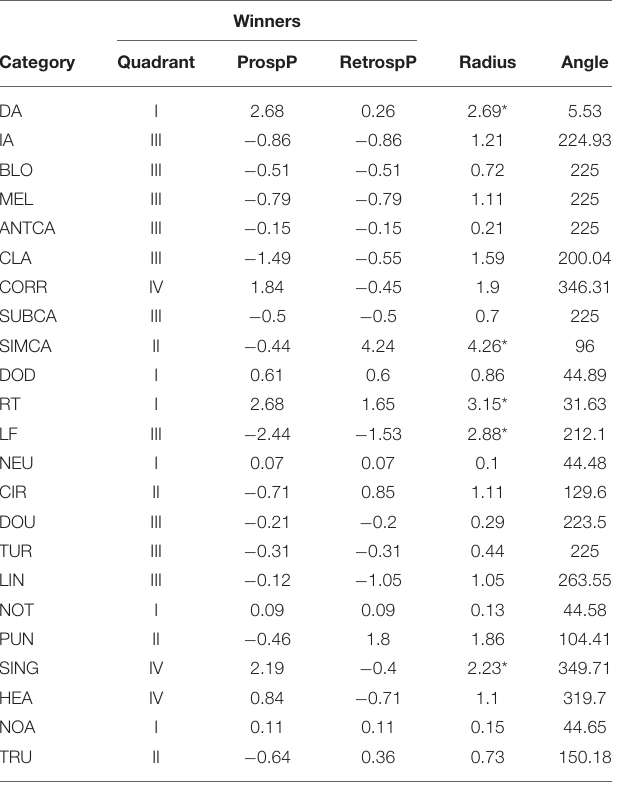
TABLE 8 | Results of the polar coordinate analysis for the 4P focal category in winners. Winners